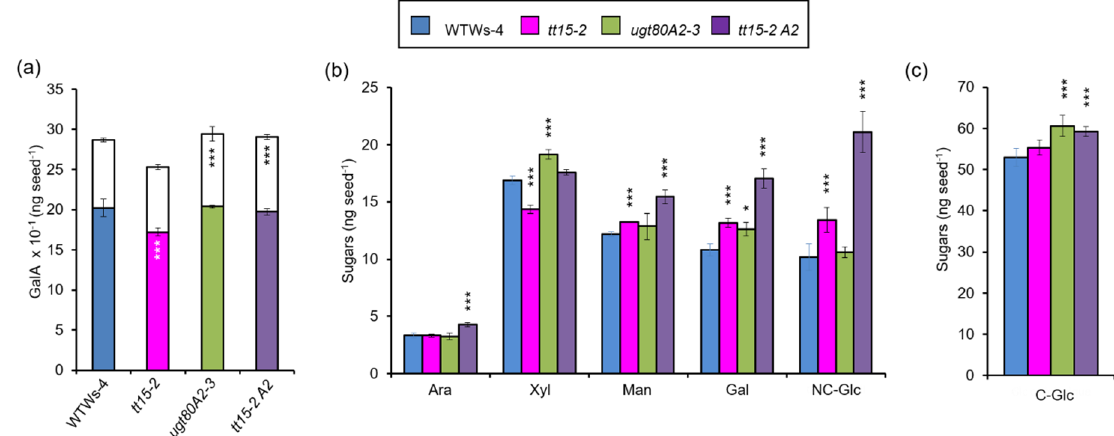
Cells 2021 , 10 , x FOR PEER REVIEW